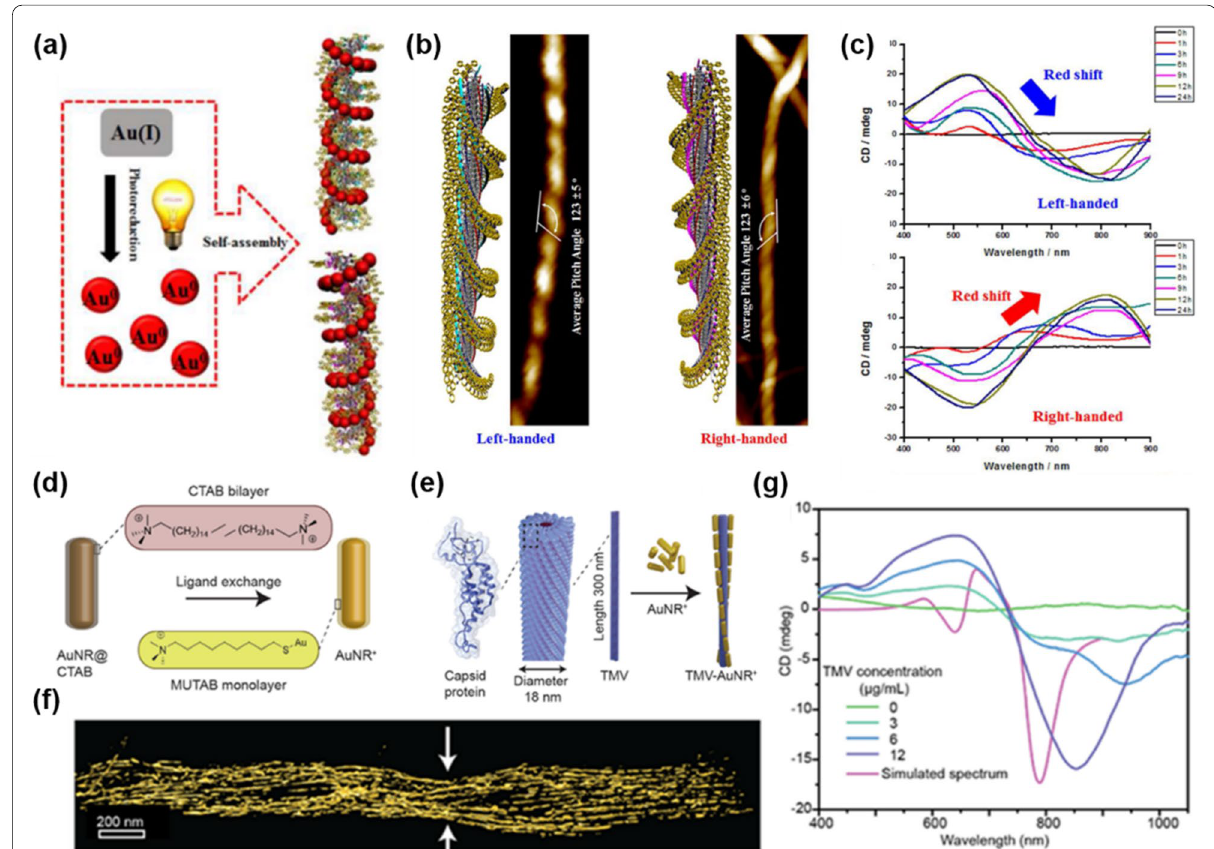
Fig. 19 a Overview of helical nanofiber-guided chiral assembly of gold NPs. b Models (left) and AFM images (right) of helical nanofibers. c CD spectra of hydrogel containing Au (I) ions after UV irradiation for reductive growth of gold NPs on the helical nanofibers. Reproduced with permission from [14]. d Schematic of the functionalization of AuNR@CTAB with MUTAB via ligand exchange method. e Cartoon representation of the TMV structure and the schematic presentation of the electrostatic interaction between TMV and AuNR + . f 3D reconstruction image with arrows pointing to the helical twist. g Experimental CD spectra showing stronger signals with gradually higher TMV concentration, along with the simulated CD spectrum calculated from the AuNR + coordinates obtained from f . Reproduced with permission from